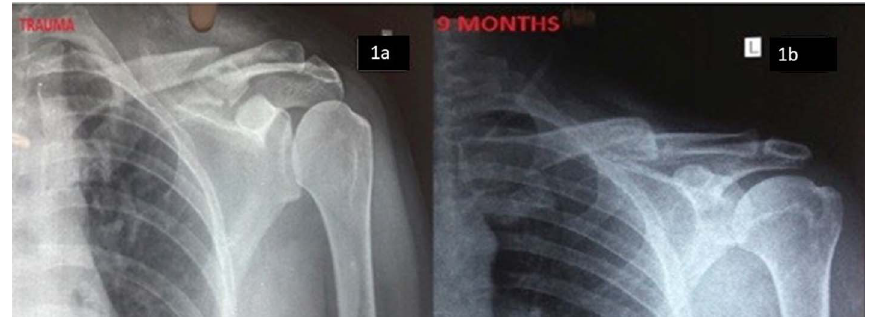
Figure 1. (a) Clavicle fracture, managed with brace (1b) Union with a good result after 9 months.